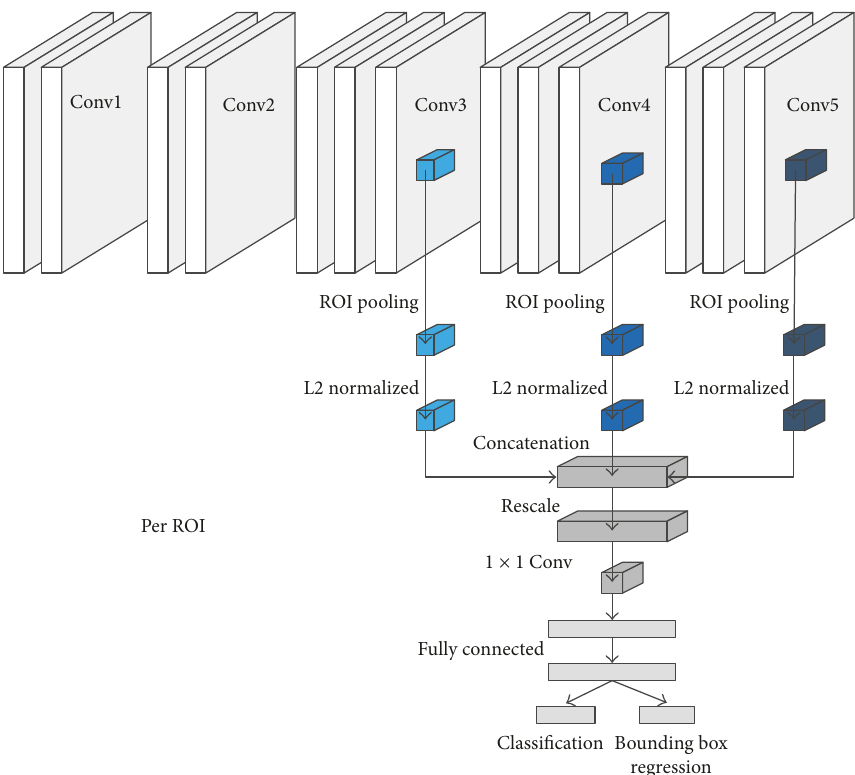
Figure 3: The model structure of the proposed